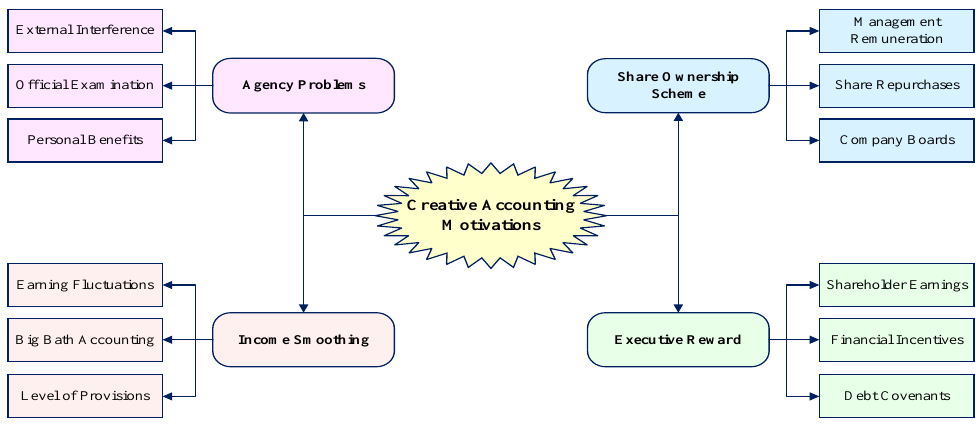
Figure 2. Motivations behind creative accounting. Source: Own elaboration.